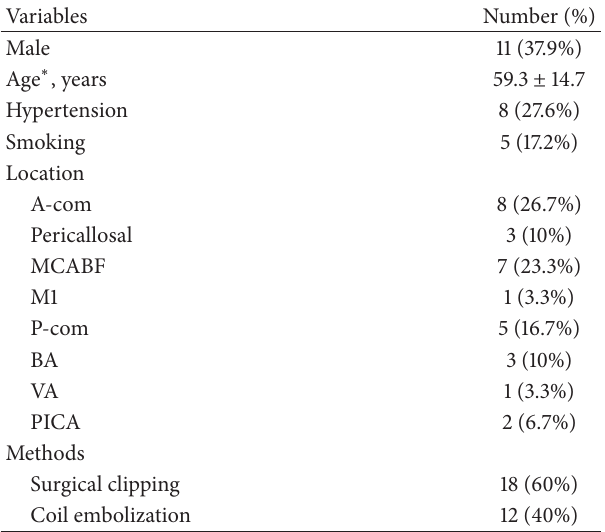
Table 1: Clinical characteristics of 29 Fisher grade III SAH patients harboring 30